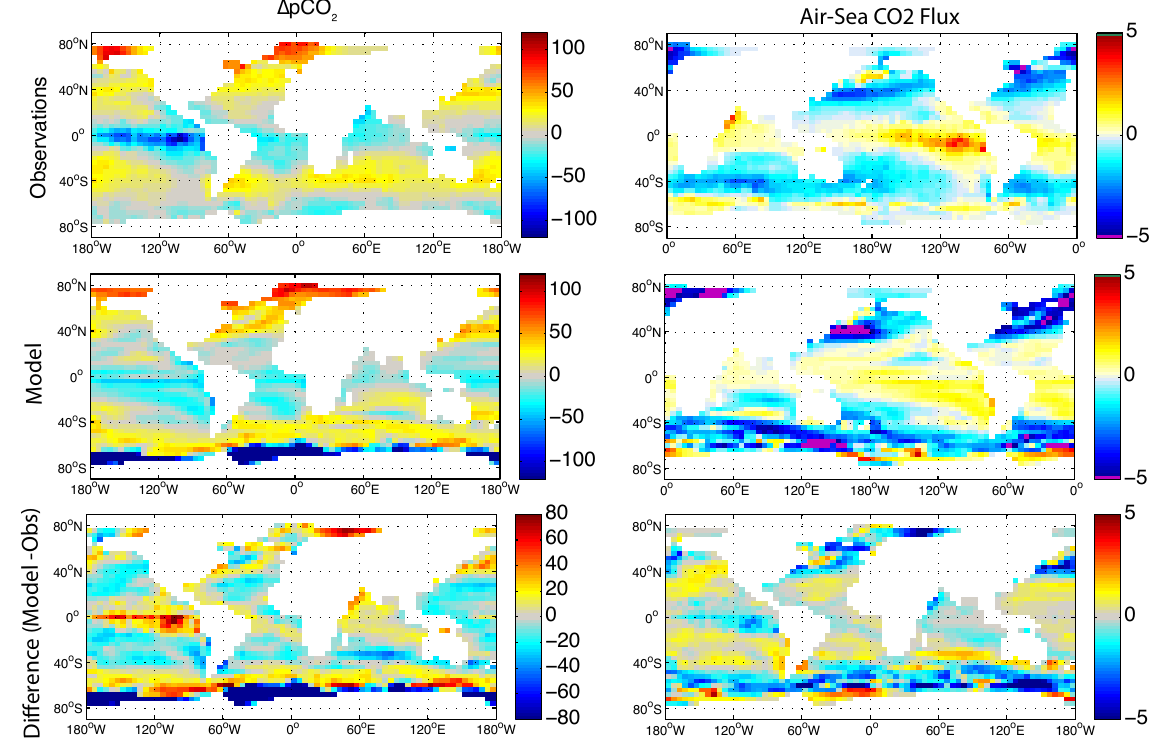
Fig. 16. Air-sea disequilibrium ( 1p CO 2 , ppm, left column) and CO 2 fluxes (positive upward, molCm − 2 yr − 1 , right column). Observations from Takahashi et al. (2009), referenced to 2000 (top), simulated mean for year 2000 (middle) and their difference (bottom). Model results were interpolated to the 4 ◦ × 5 ◦ grid used by Takahashi et al. (2009).